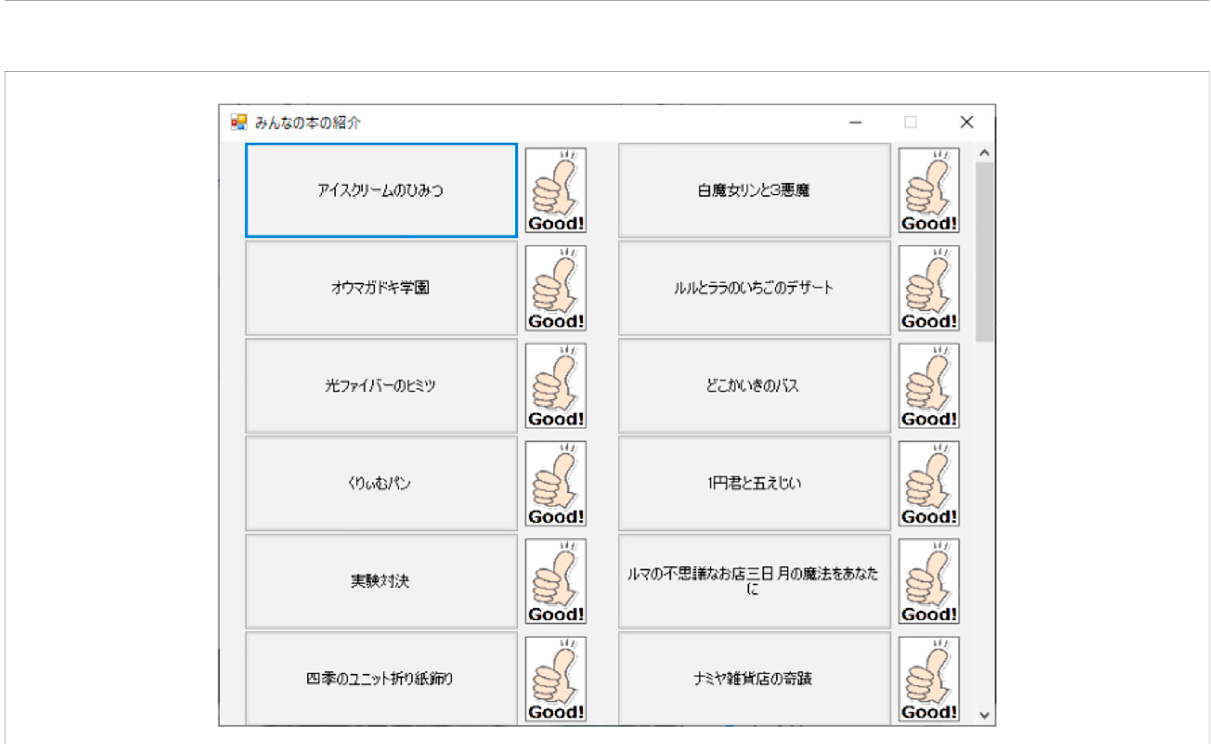
FIGURE 8 Screenfor returningratings during thefeedback application.Childrenwholistento thecontent introductionpressthegood buttoniftheyliked the introduction content of the